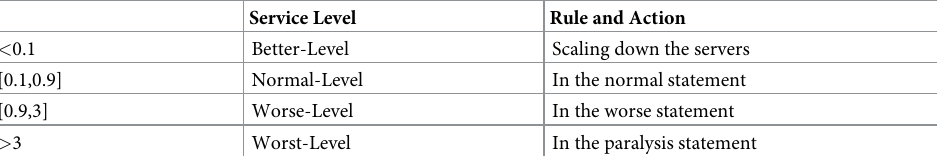
Table 2. The description of the